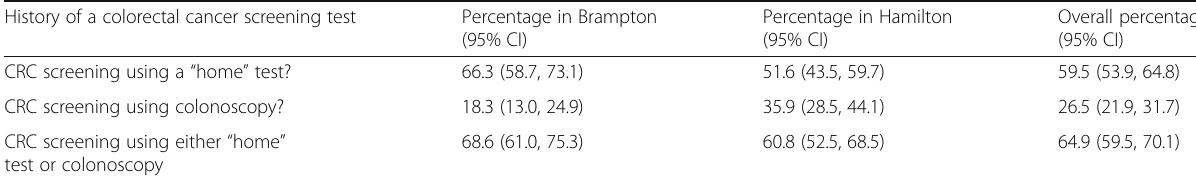
Table 3 Colorectal cancer screening uptake and intention History of a colorectal cancer screening